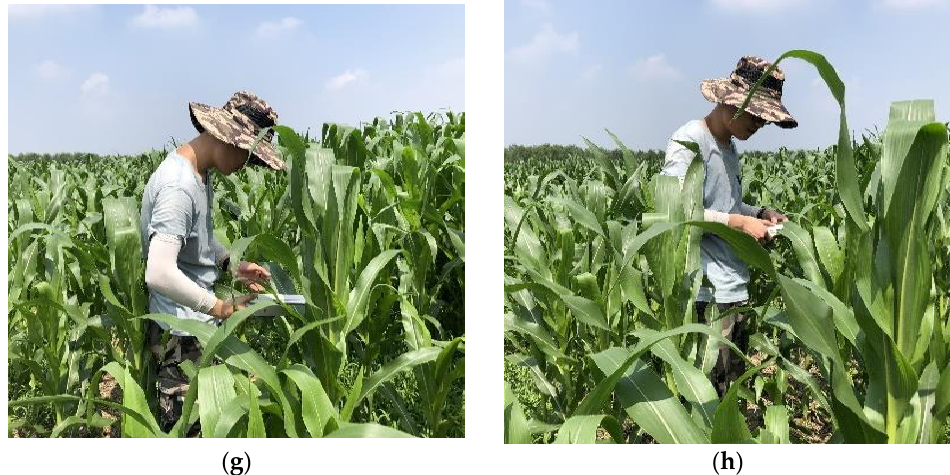
Figure 2. The acquisition instrument of data. ( a ) Yaxin1242; ( b ) plant stratification; ( c ) PSR1100-f; ( d ) SPAD502 Plus; ( e ) M210&MS600 Pro; ( f ) DJI Phantom 4 RTK; ( g ) manual collection of LAI data; ( h ) manual collection of SPAD data.